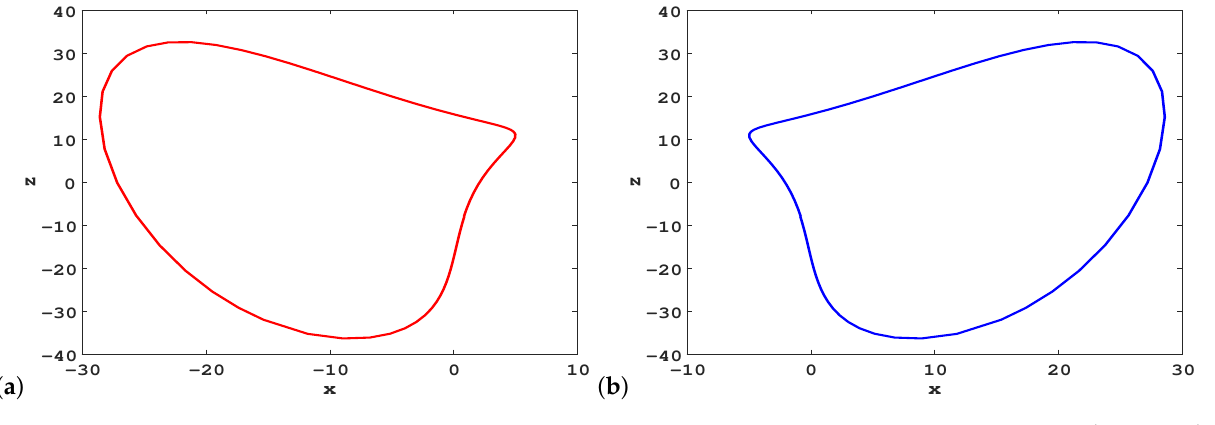
Figure 14. Two shortest periodic orbits in system (2) for parameters ( a , b , c , k , m ) = ( 10,100,2.7, − 0.2,1 ) ; ( a ) cycle 2; ( b ) cycle 3.